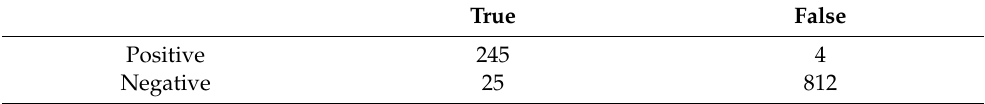
Table 8. Confusion matrix of k-NN classifier applied five days before the swarming event. True